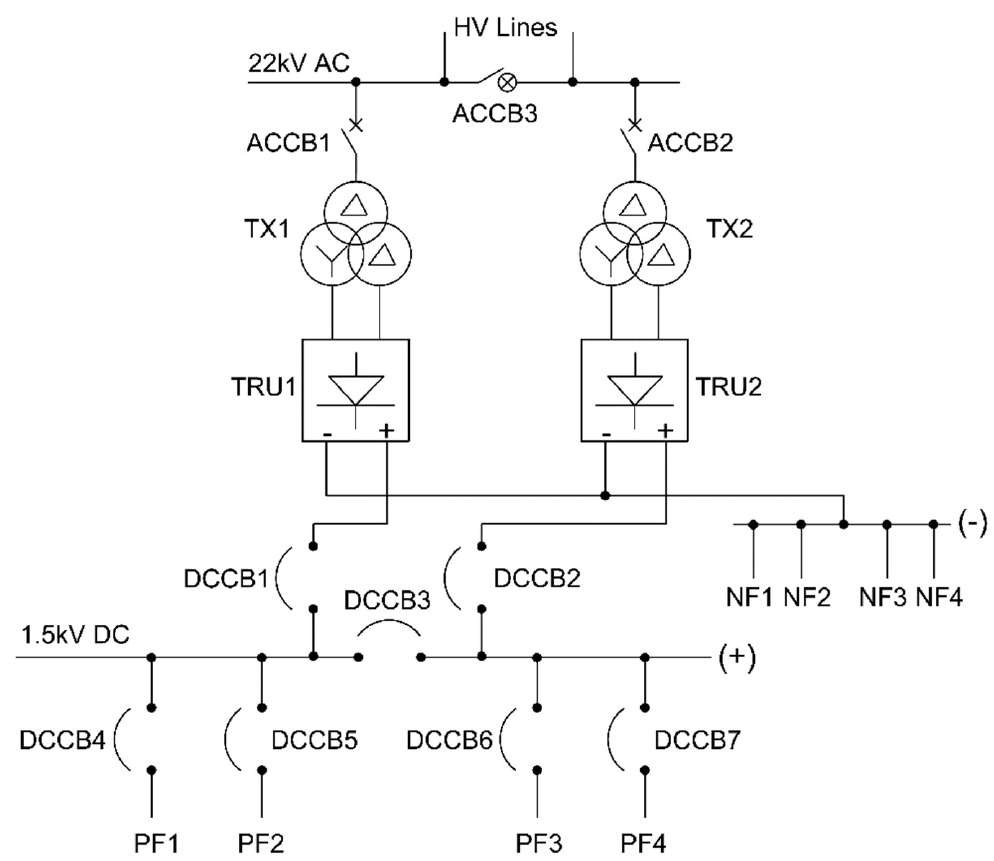
Figure 2. DC substation feeding arrangement.